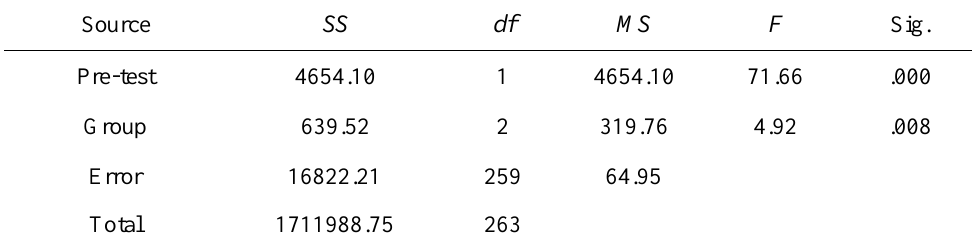
Table 3 Analysis of Co-Variance for English Performance by Groups